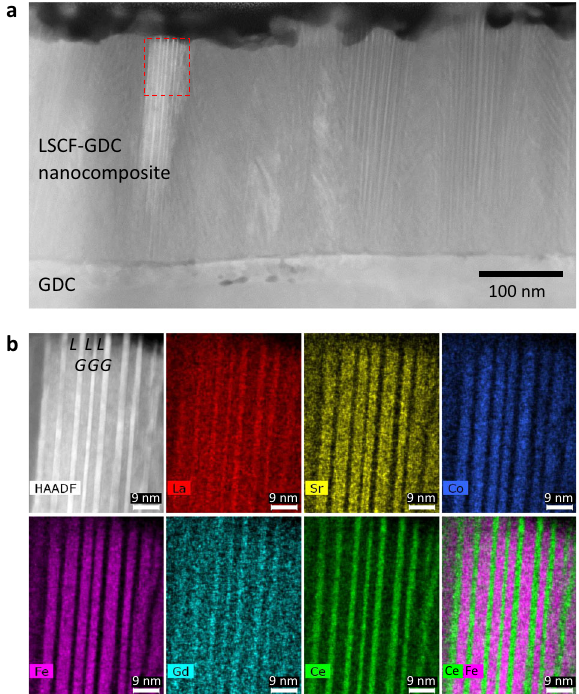
Fig. 1 Microstructure and phase distribution of the LSCF-GDC nanocomposite fi lm. a Low-magni fi cation STEM-HAADF image showing the existence of self-assembled nanostriped patterns with long-range ordering across the thickness of the LSCF-GDC nanocomposite fi lm. b STEM-HAADF and STEM-EDX elemental distribution of the various elements comprising LSCF (La, Sr, Co, Fe) and GDC (Gd, Ce) phases within the area denoted by a dashed rectangle in a . On the STEM-HAADF image, LSCF and GDC regions are denoted by the letters L and G ,